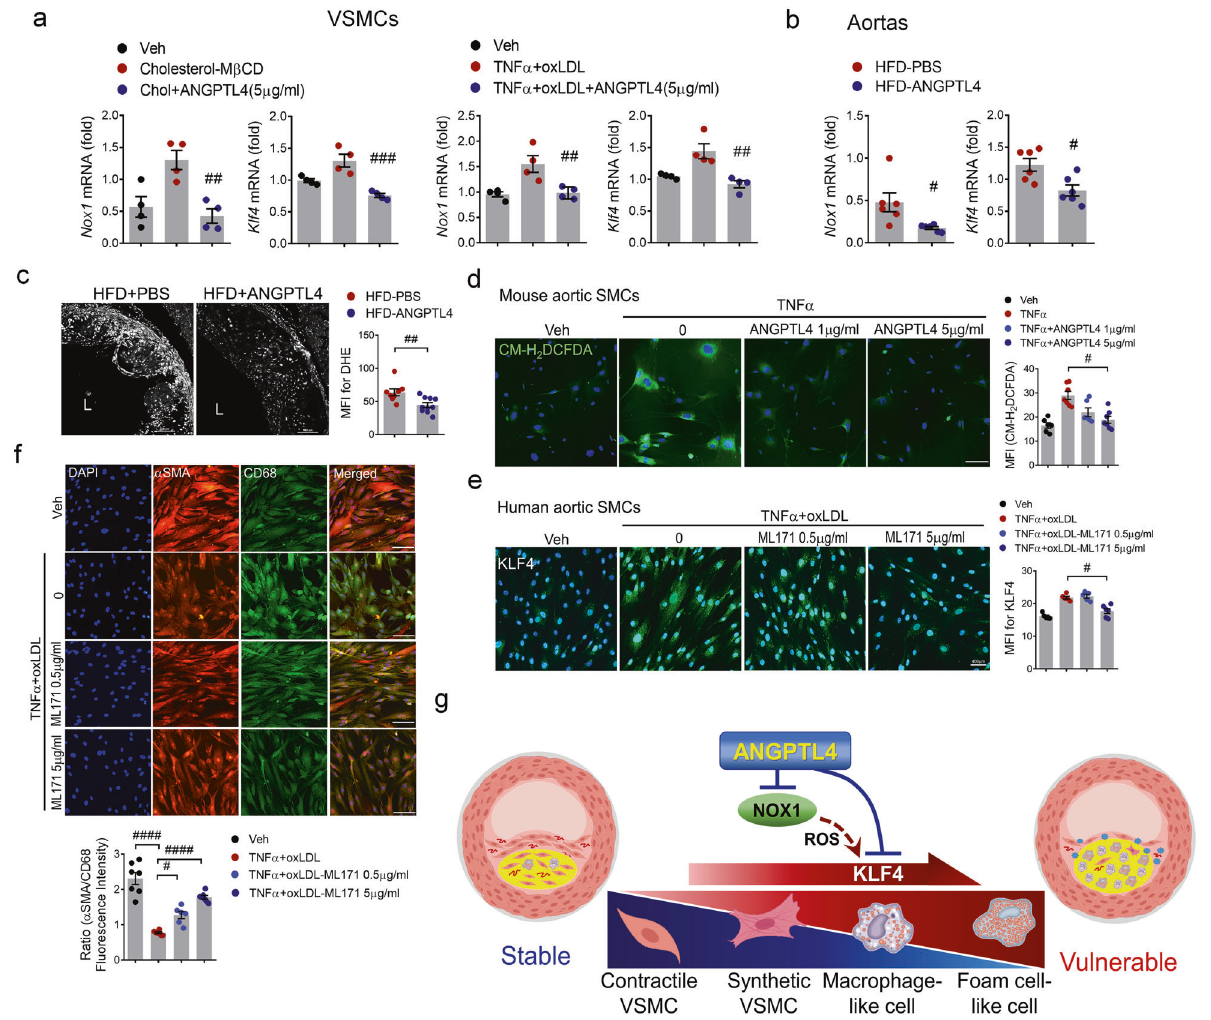
Fig. 7 ANGPTL4 modulates SMC phenotypic changes through KLF4 induction by NOX1. a Aortic SMCs pretreated with ANGPTL4 were stimulated with cholesterol (10 μ g/ml) or oxLDL (10 μ g/ml) and TNF α (100 ng/ml), and the levels of Nox1 and KLF4 were measured. b Aortas were isolated from atherosclerotic Apoe − / − mice treated with PBS or ANGPTL4, and the levels of Nox1 and KLF4 were measured. c Representative images and quanti fi cation of dihydroethidium (DHE) fl uorescence in aortic root sections. The aortic root sections were incubated with 5 μ M DHE for 10 min in the dark. The data presented are the MFI of DHE (mean ± SEM, n = 9). Scale bar, 100 μ m. d Representative images of CM-H 2 DCFDA staining. Aortic SMCs from atherosclerotic Apoe − / − mice were pretreated with ANGPTL4 and TNF α and exposed to 13 μ M CM-H 2 DCFDA. Quanti fi cation of ROS levels by MFI. Scale bar, 100 μ m. e , f Human aortic SMCs were stimulated with oxLDL (10 μ g/ml) and TNF α (100 ng/ml) with or without ML171, a NOX1 inhibitor (0.5 μ g/ml, 5 μ g/ml), and were stained with KLF4 ( e ) and α - SMA and CD68 ( f ). Scale bar, 100 μ m. g Proposed mechanism of action for ANGPTL4 administration in atherosclerosis and plaque stabilization. Data were presented as the mean ± SEM. # p < 0.05, ## p < 0.01, ### p < 0.001, #### p < 0.0001 (by Student ’ s t -test or one-way ANOVA with Bonferroni ’ s multiple-comparisons